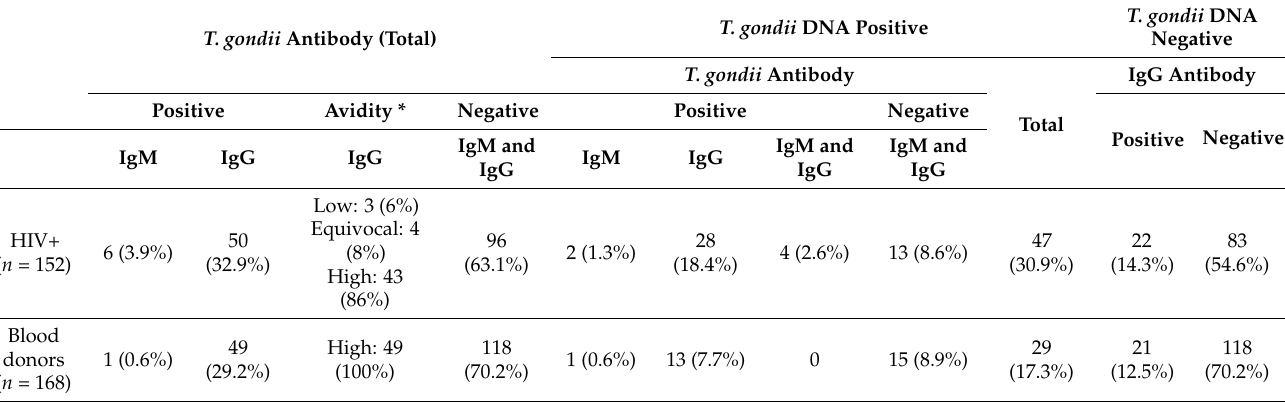
Table 2. T. gondii infection markers (IgM and IgG antibodies, IgG avidity index, and DNA) in the blood of HIV-infected patients and blood donors.